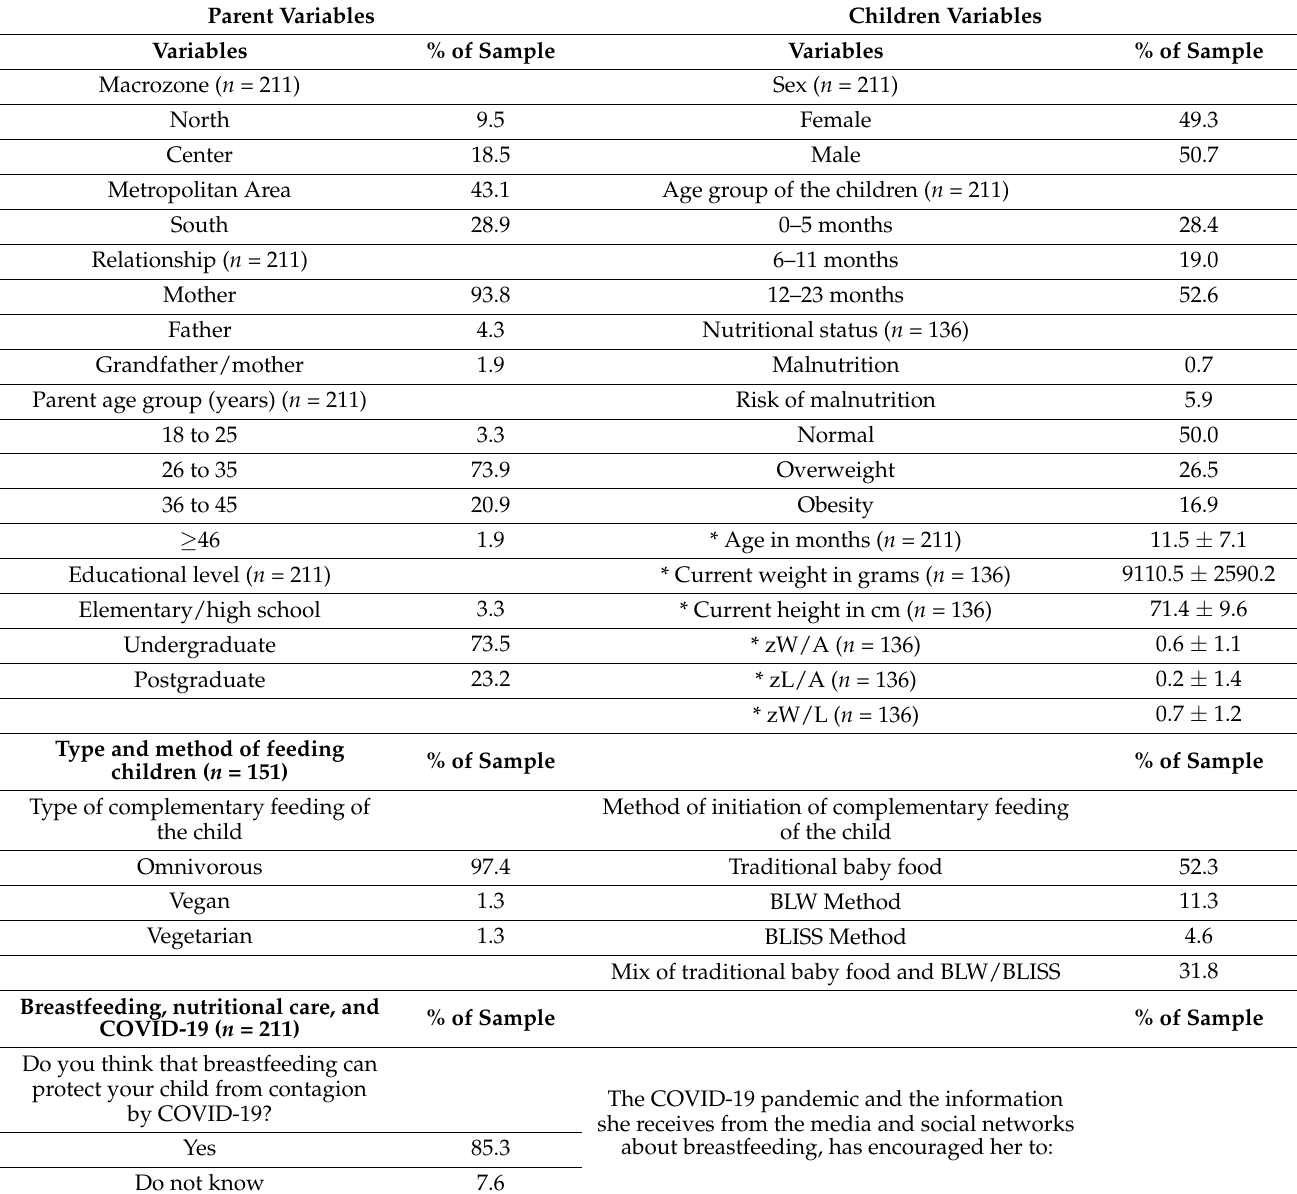
Table 1. Sociodemographic and nutritional characteristics of the study